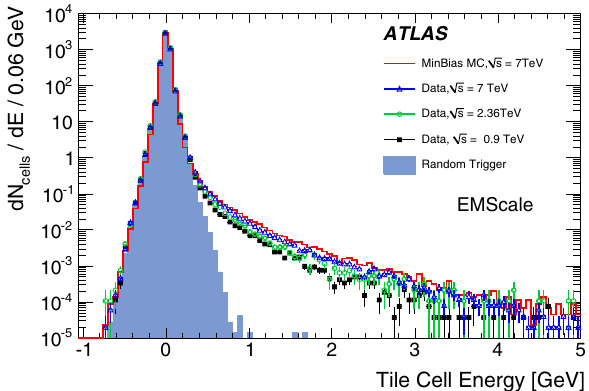
Fig. 10 The TileCal cell energy spectrum at the electromagnetic (EM) scale measured in 2010 data. The distributions from collision data at 7TeV, 2.36TeV, and 0.9TeV are superimposed with Pythia minimum- bias Monte Carlo and randomly triggered events